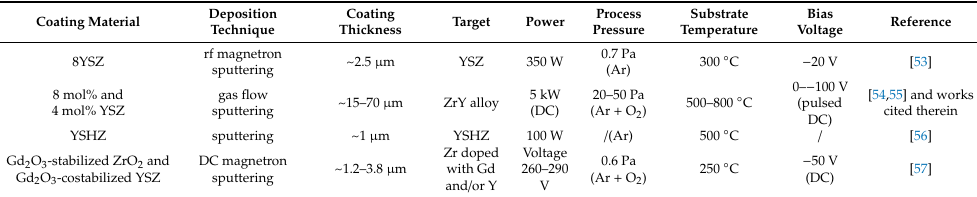
Table 5. Deposition parameters, materials and film thicknesses for the coatings deposited by sputtering in the di ff erent works described in the